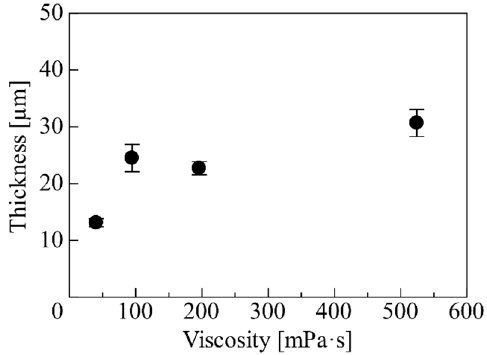
Figure 7. Thickness of baked AZP4620 with respect to change in viscosity.